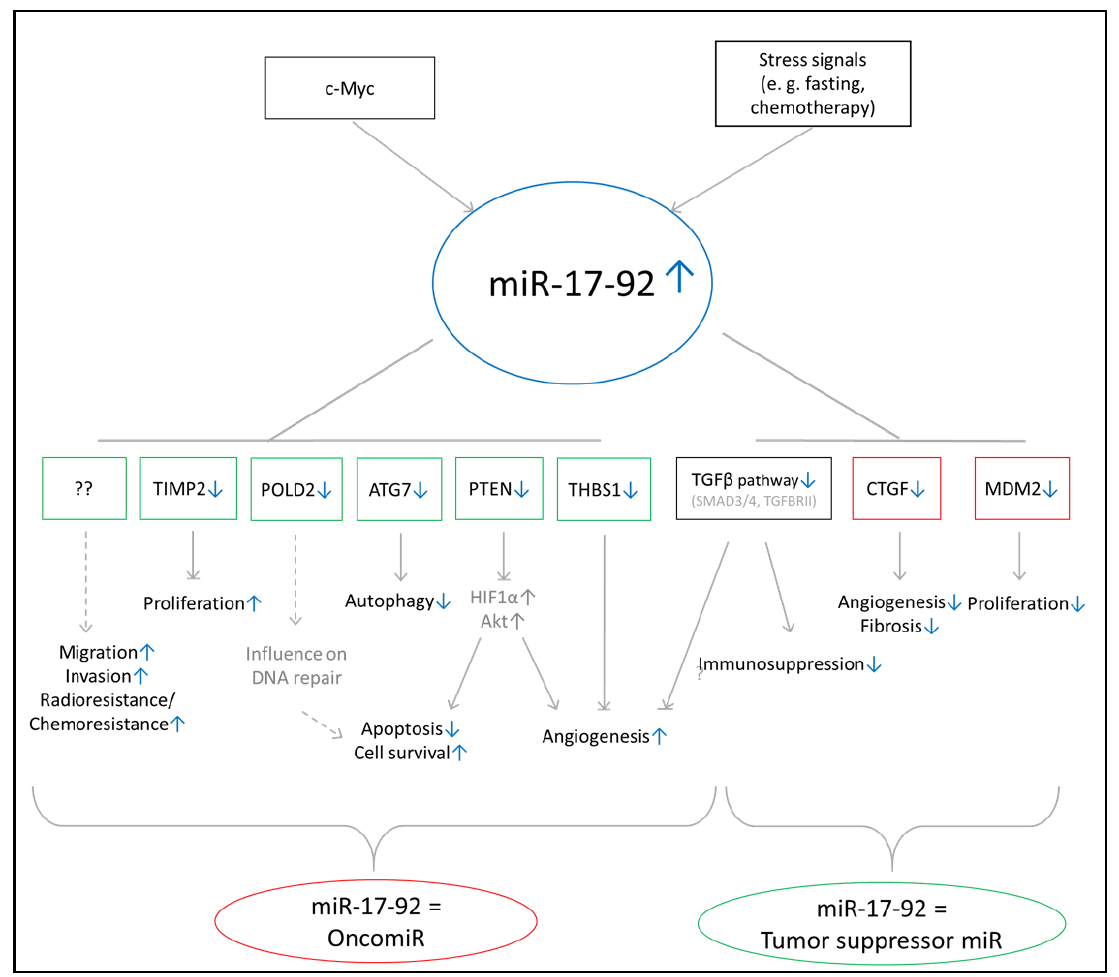
Figure 6. Summary of validated target genes and postulated cellular functions of miR-17-92. Contradictory mechanisms of action (MoAs) for this family have been proposed in previous literature (i.e., both pro-tumorigenic and tumor suppressive activities have been reported for members of the miR-17-92 cluster). Candidate target genes and their reported involvement in cellular processes are shown. Green colored framing indicates potential tumor suppressive function of corresponding gene or miR. Red colored framing indicates potenitial pro tumorigenic function of corresponding gene or miR. Blue arrows indicate direction of regulation for the corresponding pathway, miR and gene. Table 4. Summary of previously published data on the correlation between miR-17-92 expression